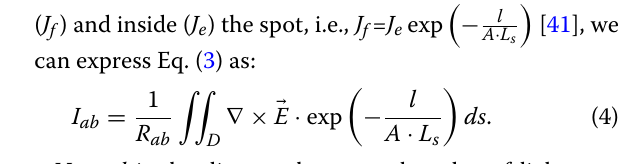
the PISHE measurement under different light power and different light profiles. Figure 2a, b shows the PISHE cur- rent as a function of light spot locations under different light power with a light spot radius of r 0 = 1.5 mm and σ = 0.5 mm and r = 1 mm and σ = 0.3 mm, respectively. 0 The symbols are the experimental data, and the solid lines are the theoretical calculations according to Eqs. (2) and (4). In the calculations, the same parameters, except for the light spot parameters, adopted in Fig. 1c are used, i.e., f 0 / q = 6.8 × 10 − 6 N · m/C, A · L s = 2.8 × 10 − 4 m, R ab = 15.5 k (cid:7) , and I c = 1/5 I m . Here, I m is the maximum